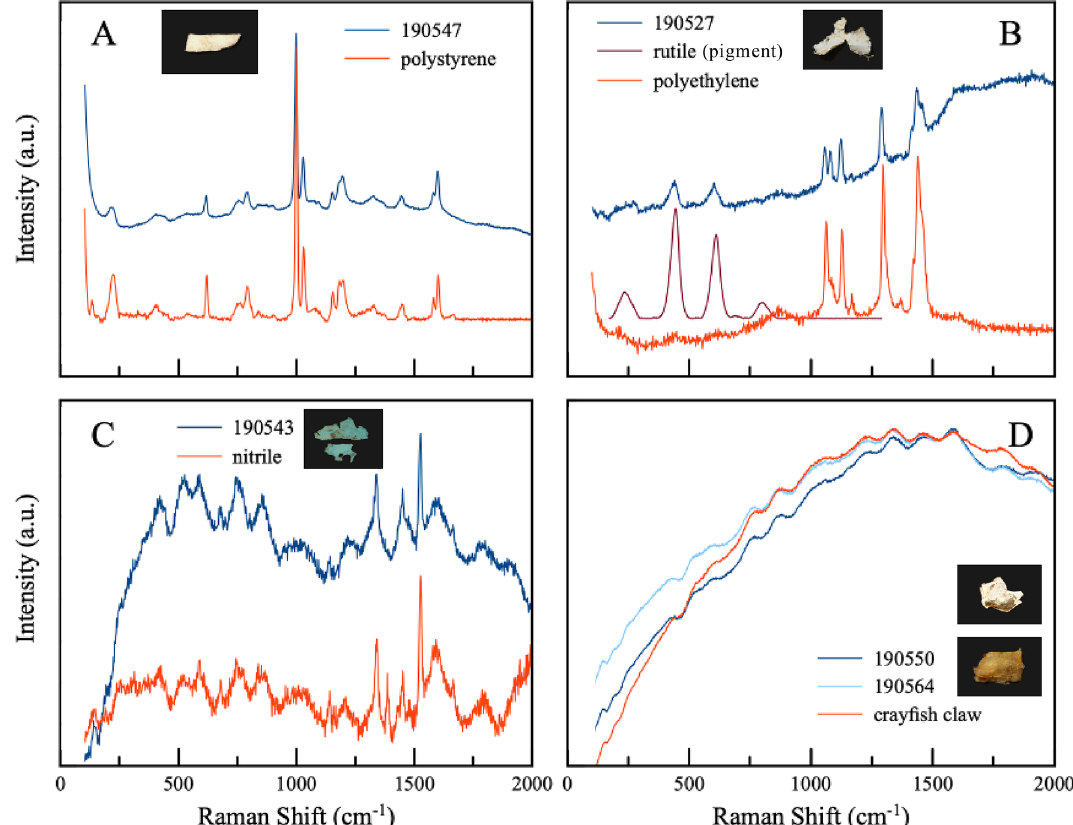
Figure 2. Characterization of plastic and plastic-resembling organic material ingested by Red-eared Sliders, Trachemys scripta elegans , from the University of California Davis Arboretum, USA. Each panel shows Raman spectra from diet sample(s) in blue and known reference material(s) in orange or dark red. In each panel, spectra are vertically offset for improved visualization, and hence the y-axis is in terms of arbitrary units (a.u.). The horizontal position of the spectral peaks is the relevant metric for confirming sample/reference match in each panel. Sample numbers correspond to LACM catalog numbers, and inset photos show the exact diet samples tested (refer to Fig.